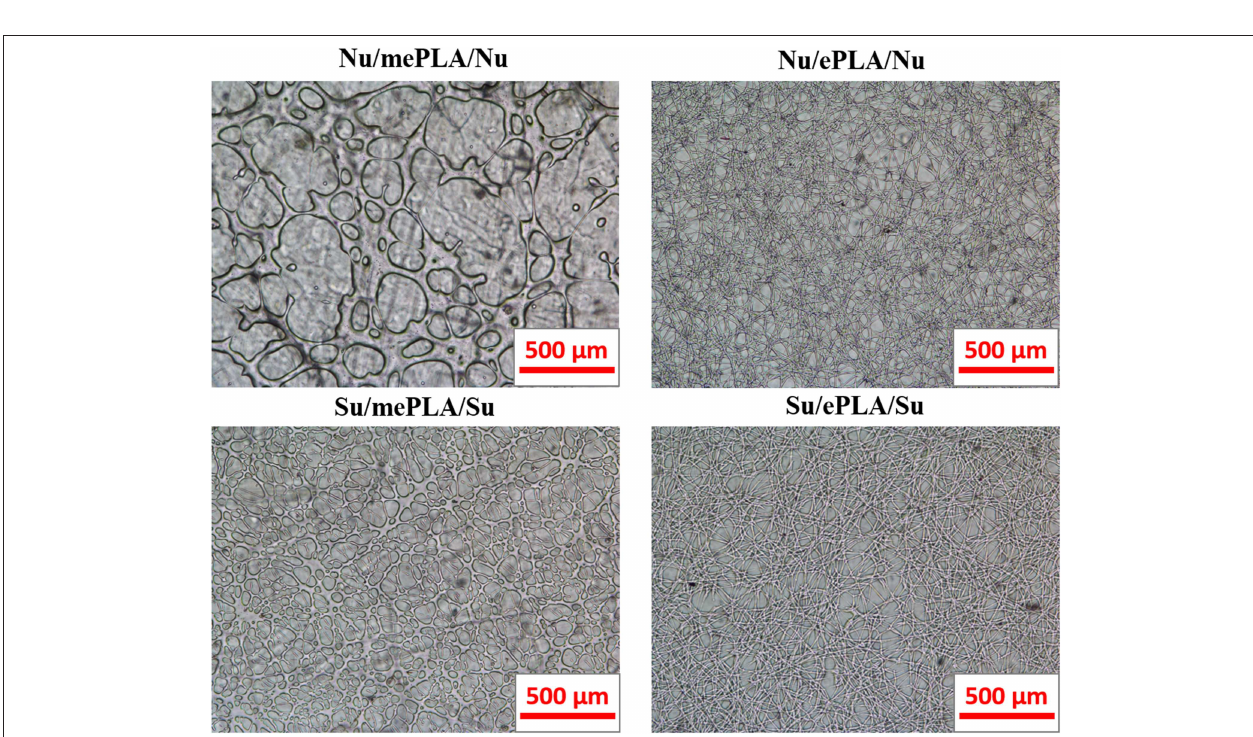
FIGURE 3 | OM images of Nucrel- and Surlyn-based multilayer composites reinforced with PLA electrospun microfibers.